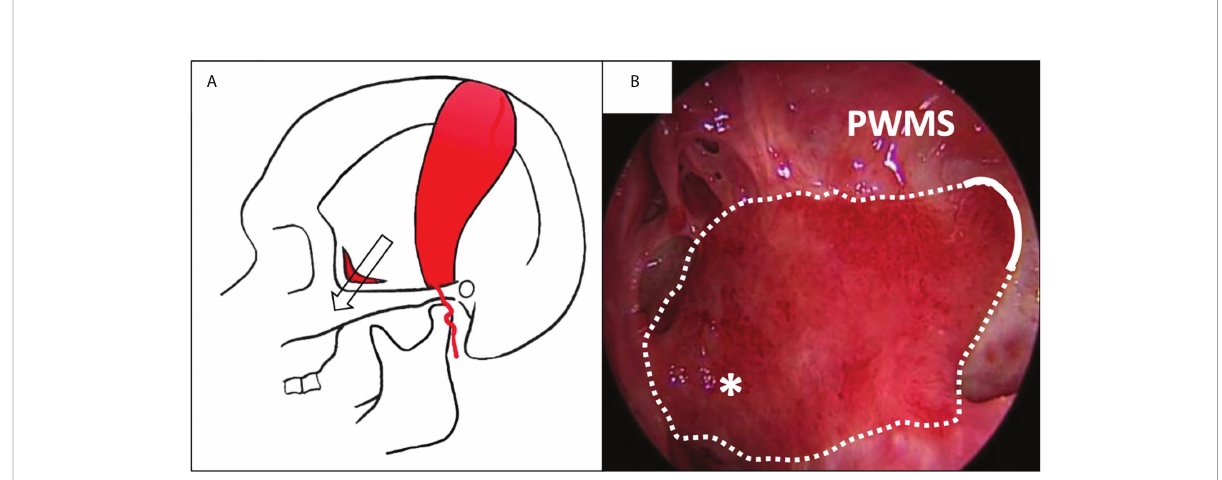
FIGURE 4 Covering of the lateral nasopharyngeal wall with a super fi cial temporoparietal fascia fl ap (sTPFF) after left endoscopic rhinopharyngectomy for recurrent nasopharyngeal carcinoma. (A) the sTPFF is pedicled on the super fi cial temporal artery; it is transposed in the nasal cavity through a temporal/infratemporal fossa tunnel (arrow). (B) Post-operative endoscopic view after 2 months: the fl ap (dotted line) has been introduced through an opening in the posterior wall of the left maxillary sinus (PWMS) and covers the lateral wall of the nasopharynx (asterisk), thus protecting the parapharyngeal internal carotid